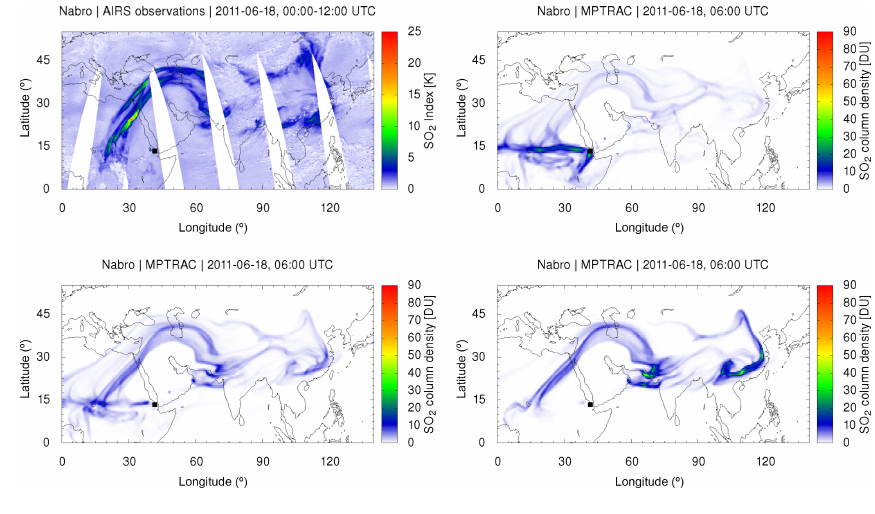
Figure 15. Same as Fig. 11, but for 18 June 2011, 06:00UTC.